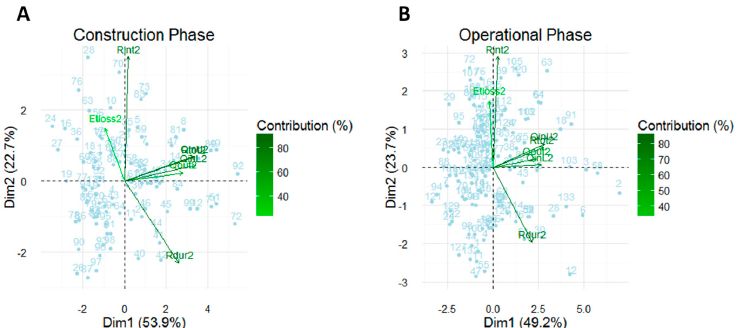
Figure 3. Principal components explain 77 ( A ) and 73 ( B ) percent of total variance in the dataset, with scaled data evenly distributed around the space formed by the components. Note that the roles of F1 and F2 are complimentary, with total rainfall playing a major role in driving flows into, through, and out of the network. Average event rainfall intensity (Rint2), duration (Rdur2) loading along F2 appear